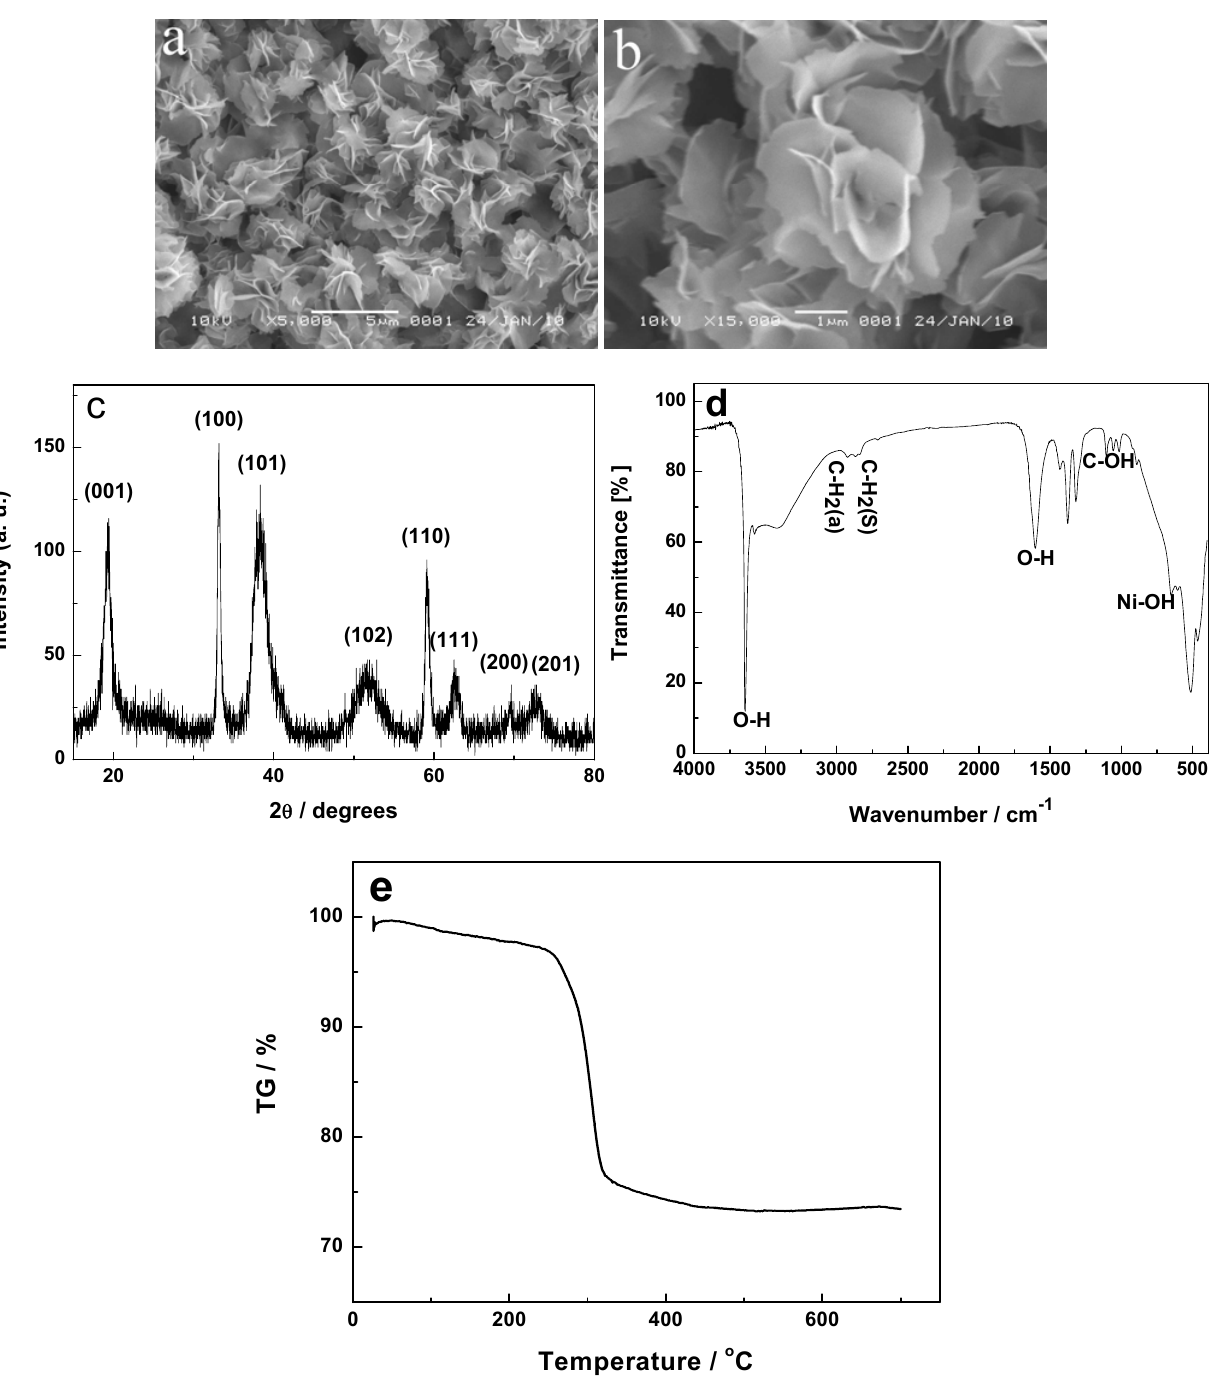
Figure 2. SEM images ( a , b ), XRD curve ( c ), FTIR spectrum ( d ), and TGA pattern ( e ) of the intermediate